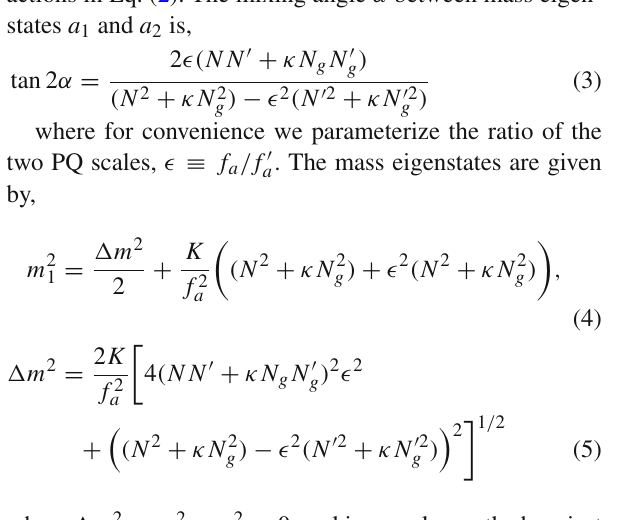
The heavier axion [Eq. (6)] has a mass the same order as